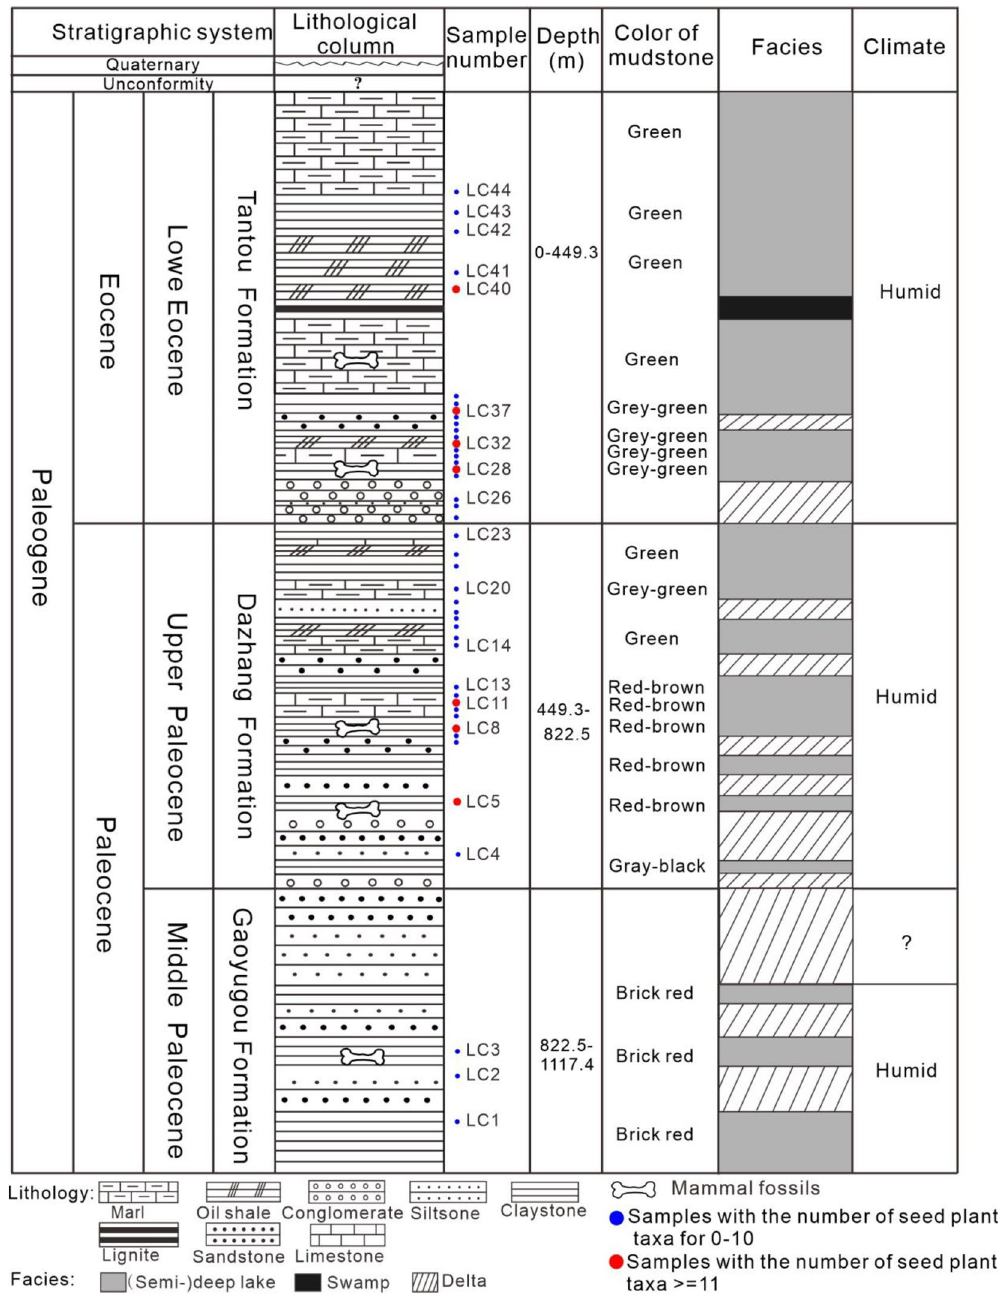
Figure 2. Sedimentary succession, geomorphic and lithologic characteristics, and sampling locations of the Luanchuan section in the Tantou Basin (modified from Du and Chen 24 ; Tong and Wang 25 and the climate mainly refers to Wang et al. 33